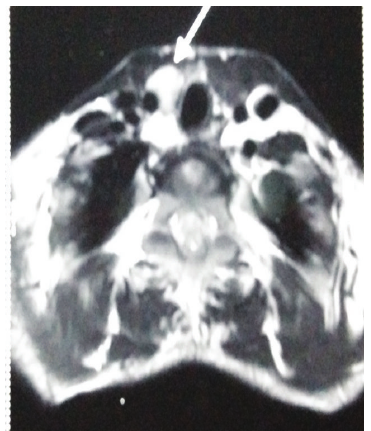
Figure 7: MRI showing lobulated lesion at the inferolateral aspect of right lobe of thyroid